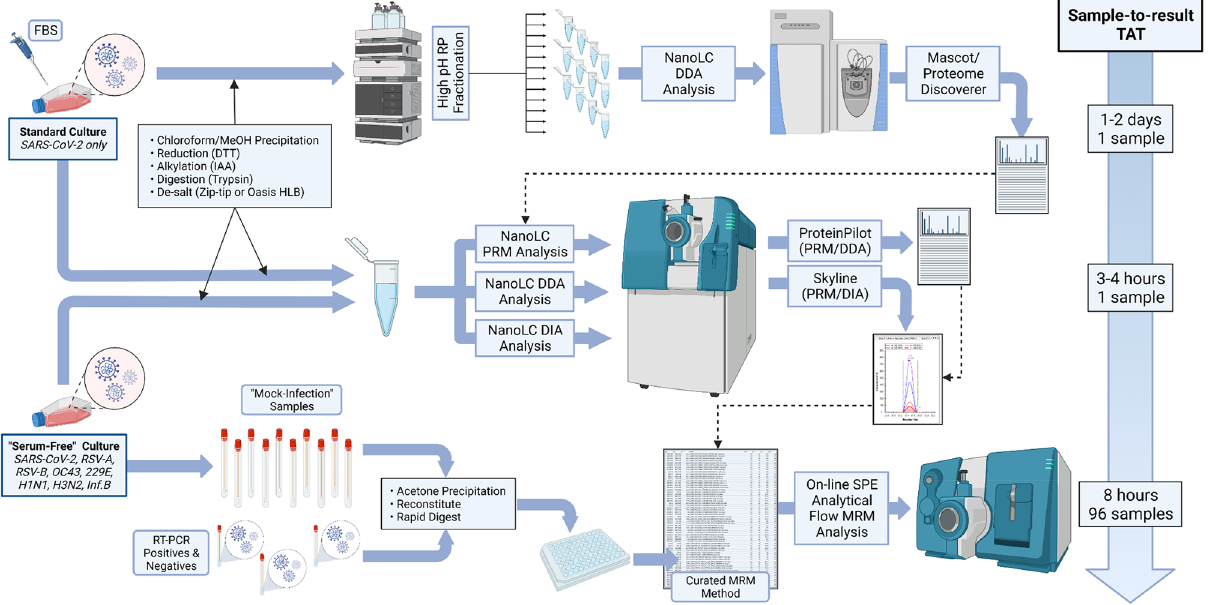
Figure 3. Graphical summary of workflow from viral cultures to rapid targeted MRM method. Use of serum- free culture avoids the need for extensive sample fractionation and use of both data-dependent and data- independent-acquisition methods during discovery phase streamlines peptide selection process. Created with